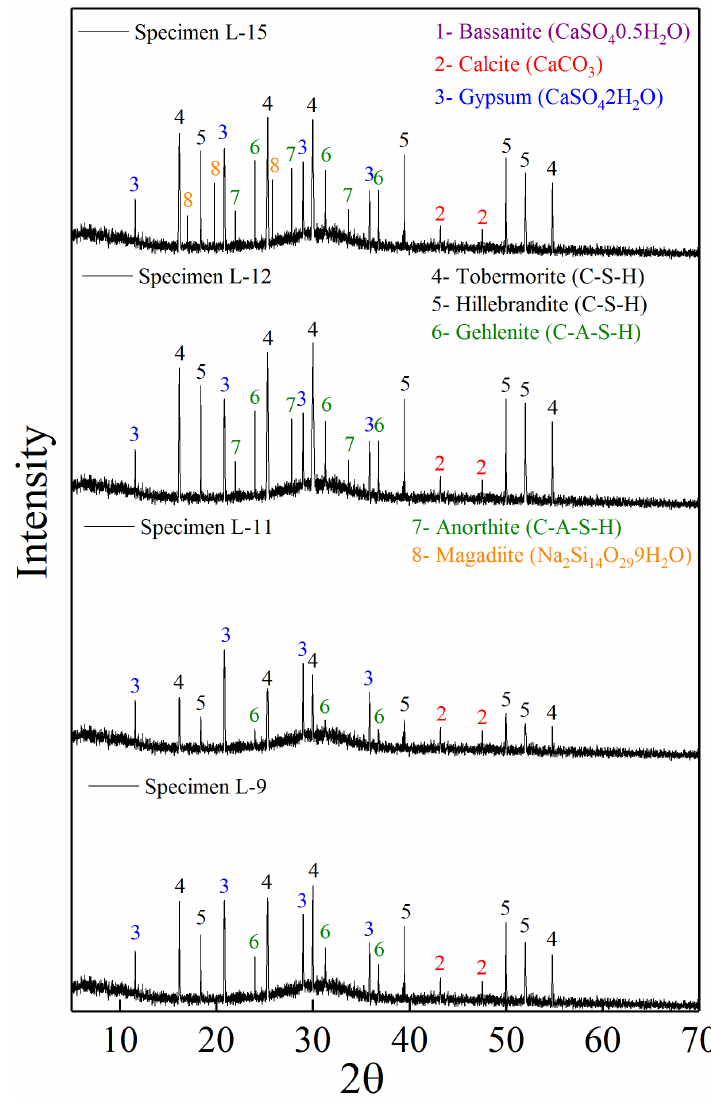
Figure 4. XRD analysis of Specimens L-9 to L-15.